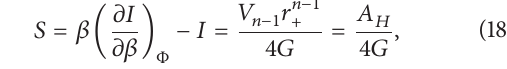
Similar to the black hole with zero charge where the partition function can be approximated from the gravity action at the saddle point, the grand partition function Z is well approximated by the gravity action of the charged black hole at the saddle (given by the classical solution since it minimizes the action).